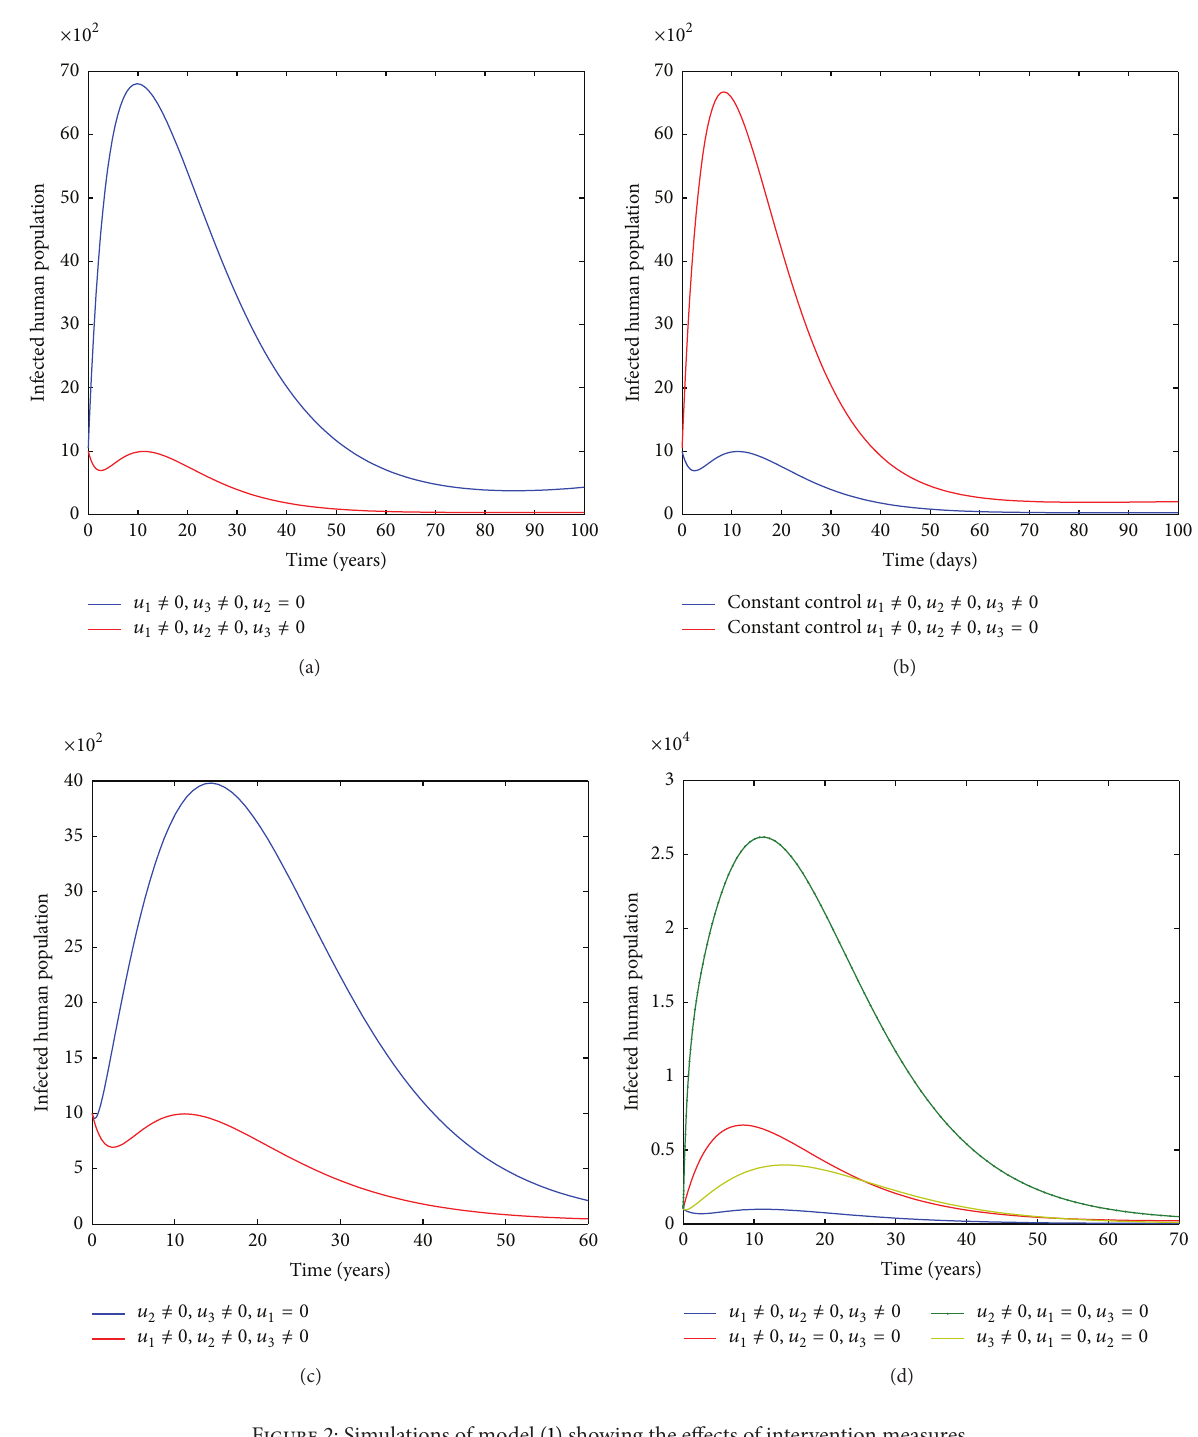
Figure 2: Simulations of model (1) showing the effects of intervention